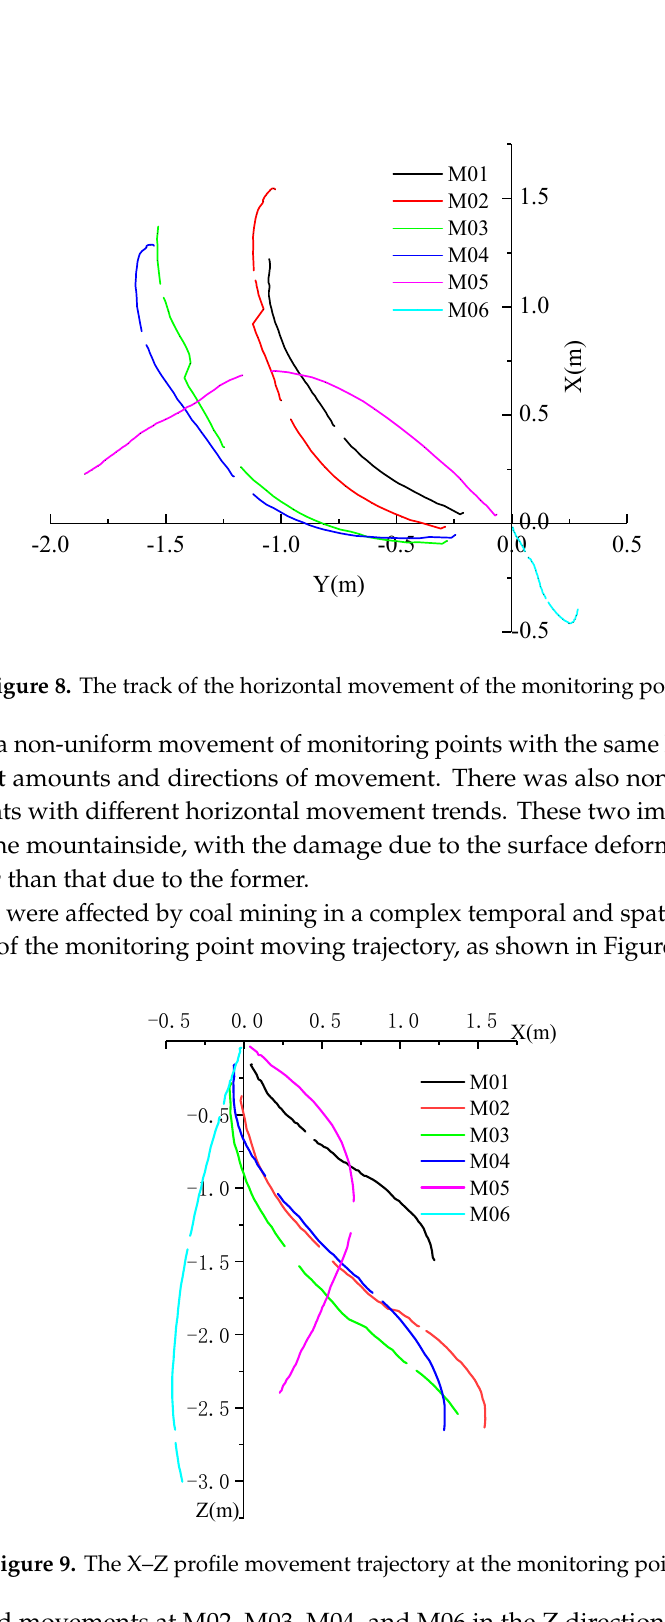
Figure 9. The X–Z profile movement trajectory at the monitoring points.